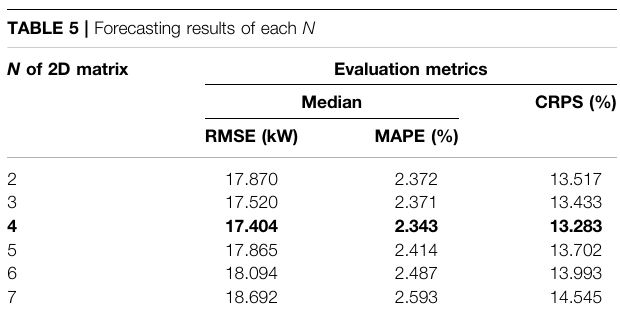
TABLE 5 | Forecasting results of each N N of 2D